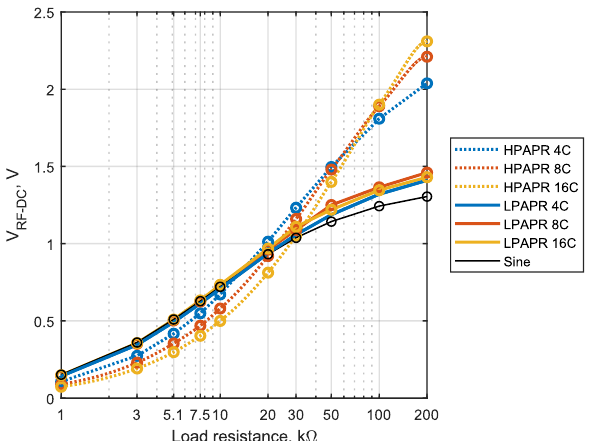
Fig. 8. RF-DC conversion output voltage for different load resistances and different signal waveforms.